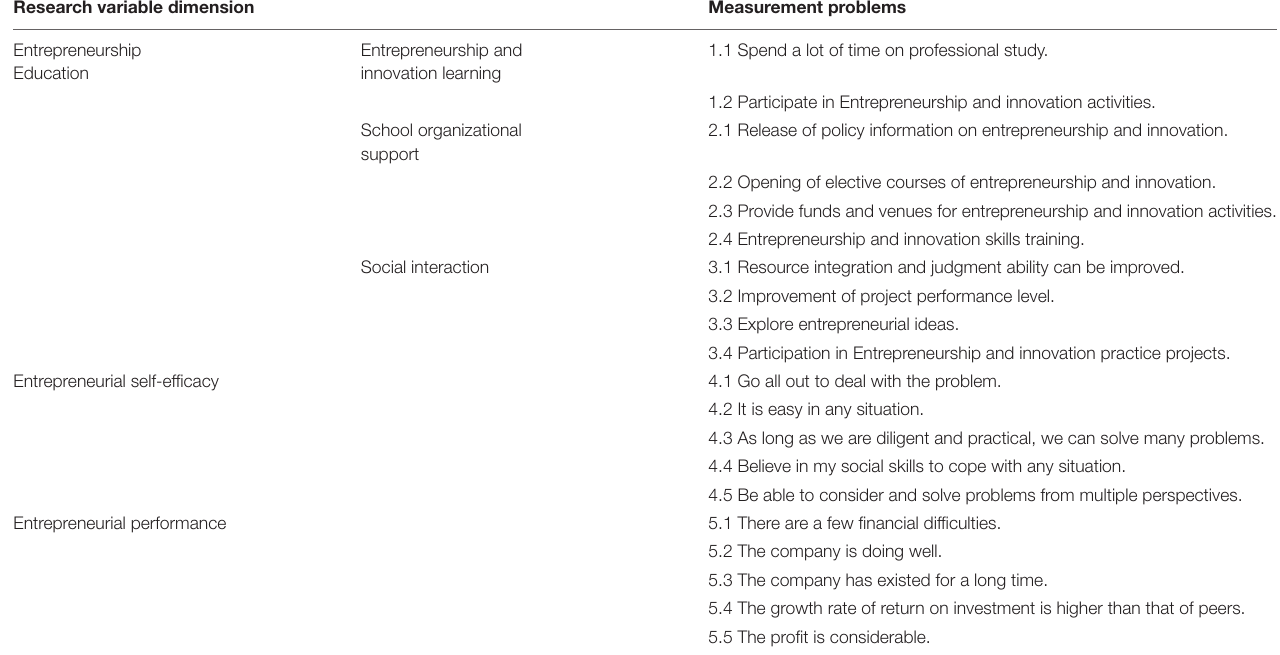
TABLE 2 | Composition of measurement scale for each research